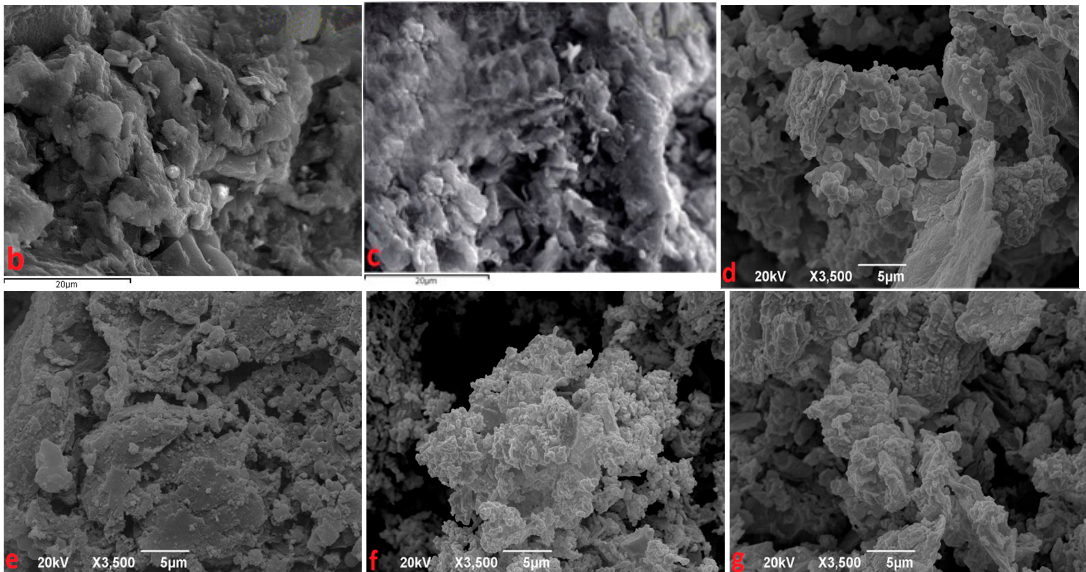
Figure 3. Scanning electron microscope (SEM) images of graphite oxide (GO) ( a ), GO–cross-linked chitosan (CS) ( b ), GO–cross-linked chitosan/magnetite (CSm) ( c ), GO–polystyrene (PS) ( d ), GO–polystyrene/magnetite (PSm) ( e ), GO–polyaniline (PANI) ( f ), GO–polyaniline/magnetite (PANIm) ( g ).